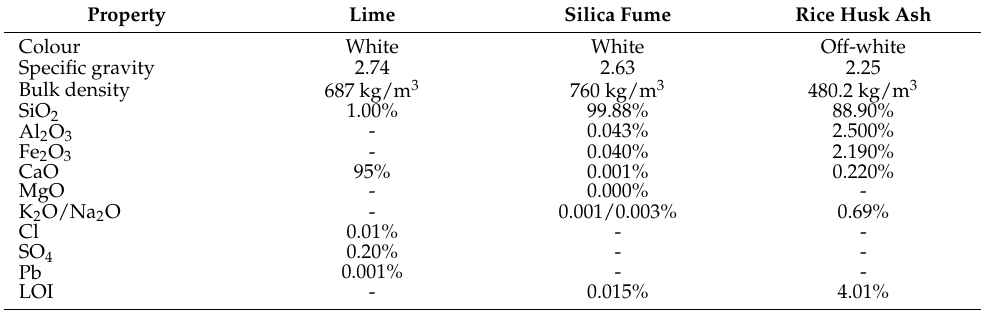
Table 1. Physiochemical properties of materials.